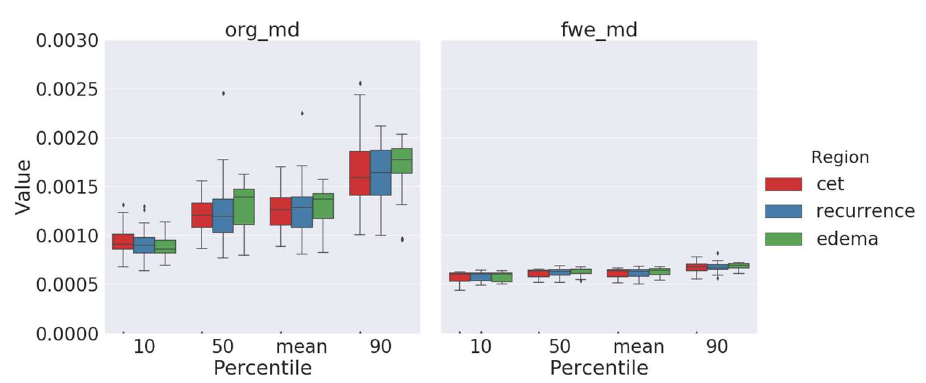
Figure 3. Original mean-diffusivity values (left) and mean diffusivity following free-water elimination (right) of contrast-enhancing tumor (red) and peritumoral edema with (blue) and without (green) later tumor recurrence. Significant differences between pure edema and edema with later recurrence were only observable in the 90th percentile of free-water-corrected MD values. Diamonds denote outliers.